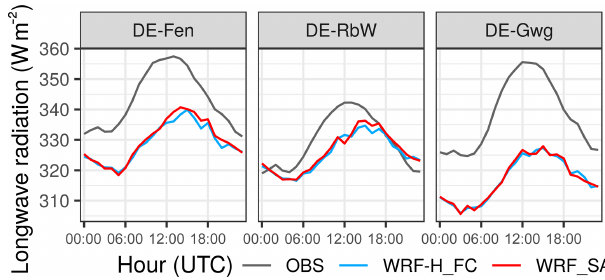
Figure 6. Mean diurnal cycles of simulated and observed downward surface shortwave radiation for June to October 2016.